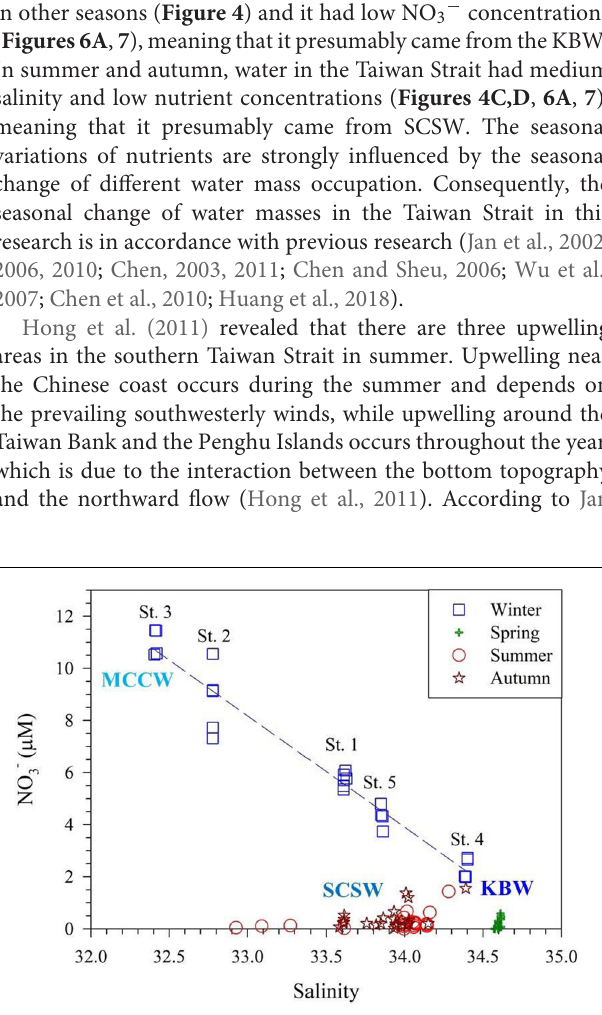
FIGURE 7 | NO 3 − versus salinity for four field campaigns in the Taiwan Strait in 2017. Three water masses, the Mixed China Coastal Water (MCCW), the Kuroshio Branch Water (KBW), and the South China Sea Water (SCSW) varies seasonally in the Taiwan